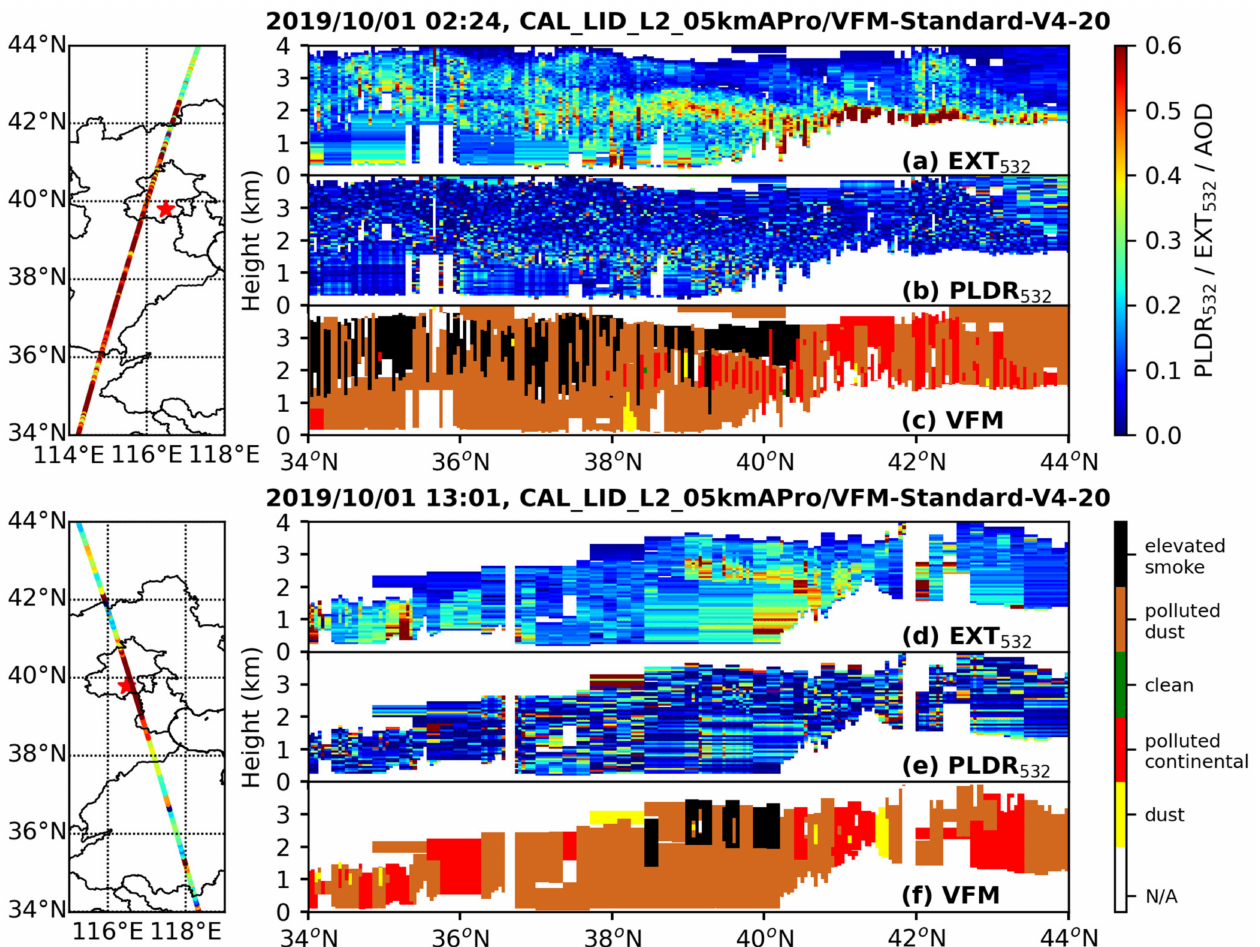
Figure 5. The CALIPSO measurements in North China on 1 October 2019. Latitude–height plots of the ( a ) extinction coefficient at 532 nm, ( b ) PLDR 532 , and ( c ) VFM at 2:24 LT. Latitude–height plots of the ( d ) extinction coefficient at 532 nm, ( e ) PLDR 532 , and ( f ) VFM at 13:01 LT. The left two panels are the CALIPSO ground tracks color-coded by AOD. The red star on the map indicates